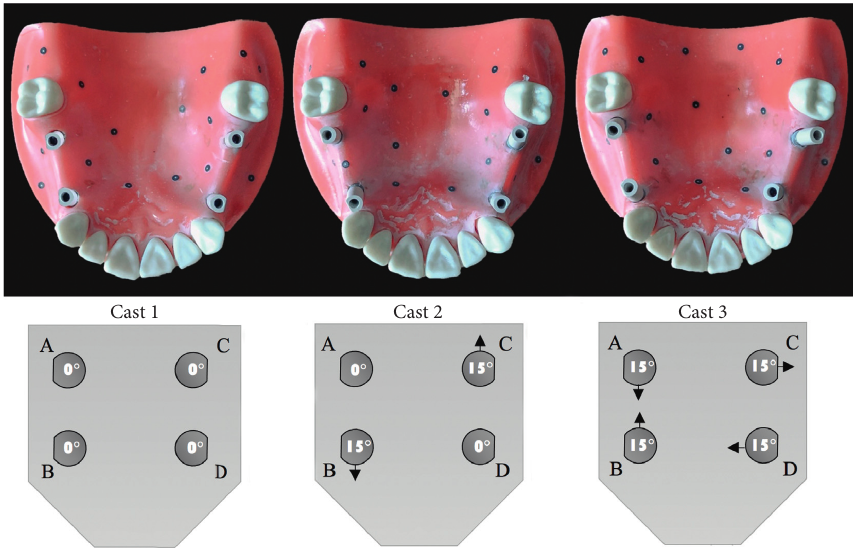
Figure 1: Implant angulations in the three models.